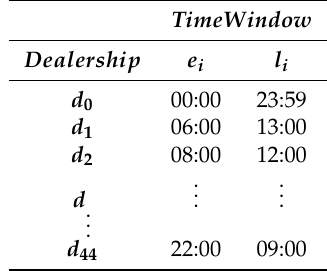
Table 3. Time windows for the dealerships in 24-h time